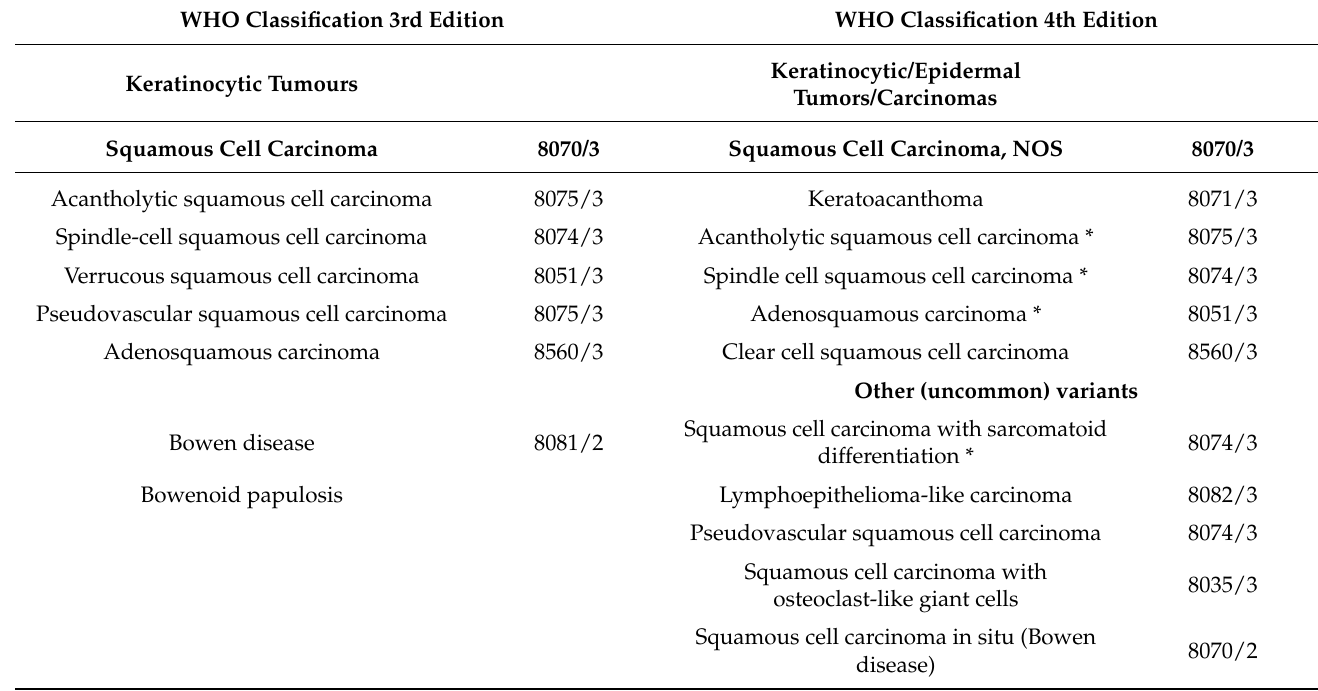
Table 1. WHO classification of skin tumors: differences between third and fourth editions. WHO Classification 3rd